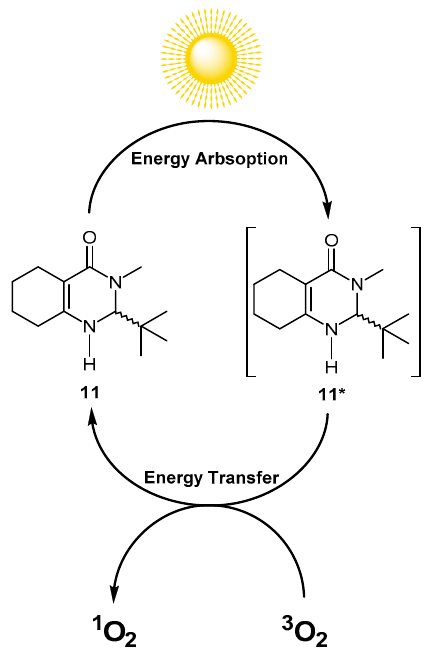
Figure 7 . Formation of singlet oxygen ( 1 O 2 ).